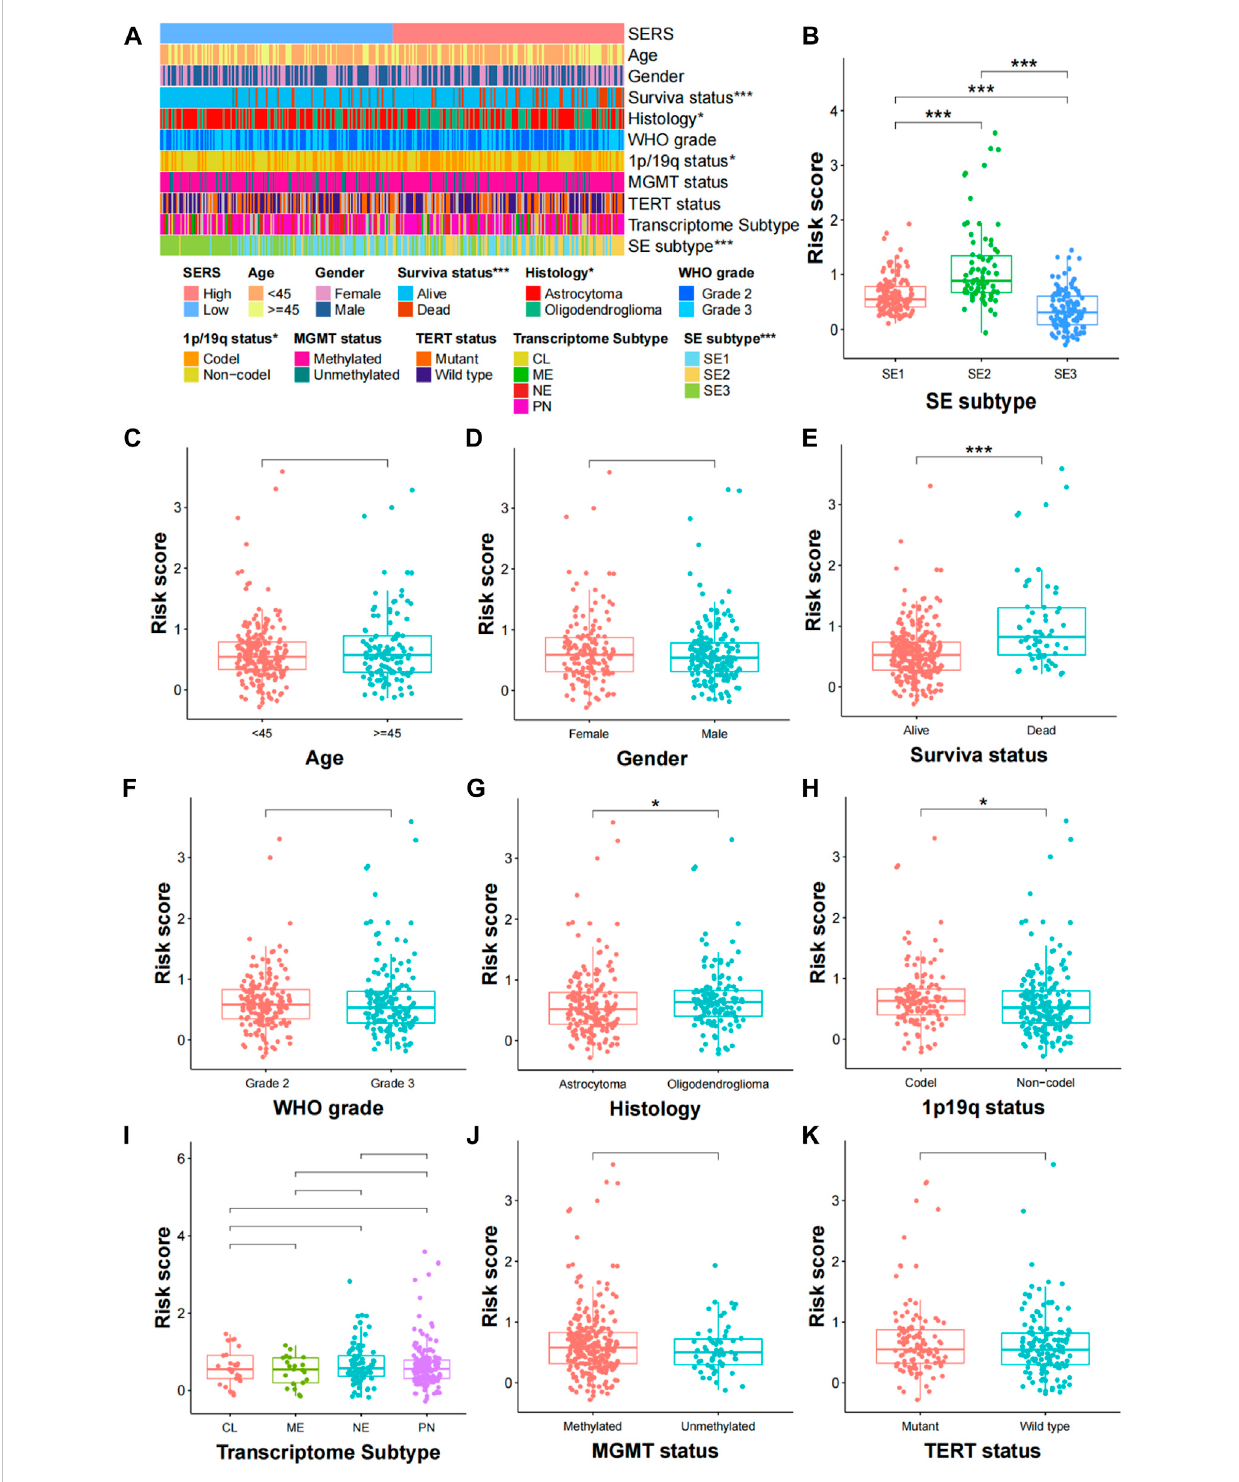
FIGURE 4 Correlation analysis between the prognostic SERS and clinicopathological characteristics in the TCGA cohort. (A) A heatmap was represented expression levels of eight selected SERS and the distribution of clinicopathological characteristics in the high- and low-risk groups, respectively. (B – K) Different levels of risk scores in glioma patients strati fi ed by age, gender, Survival status, WHO grade, Histology, 1p19q codeletion, MGMT status, SERS subtype, TERT status and Transcriptome subtype. * p < 0.05, ** p < 0.01, *** p < 0.001, and ns No signi fi